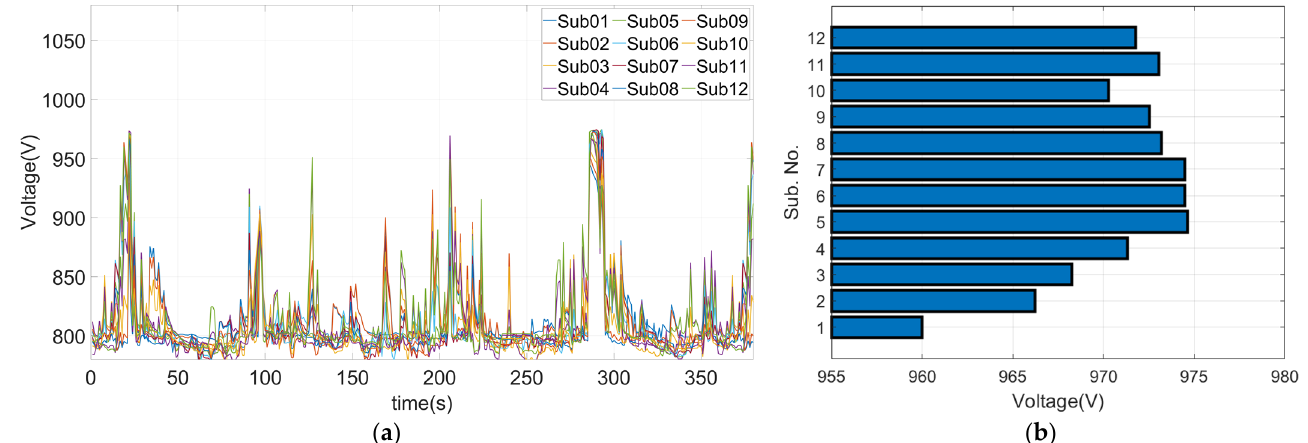
Figure 4. ( a ) Voltage profile of Incheon 2nd line’s parallel power supply system using DCPS. ( b ) Maximum voltage by each substation of Incheon 2nd line .